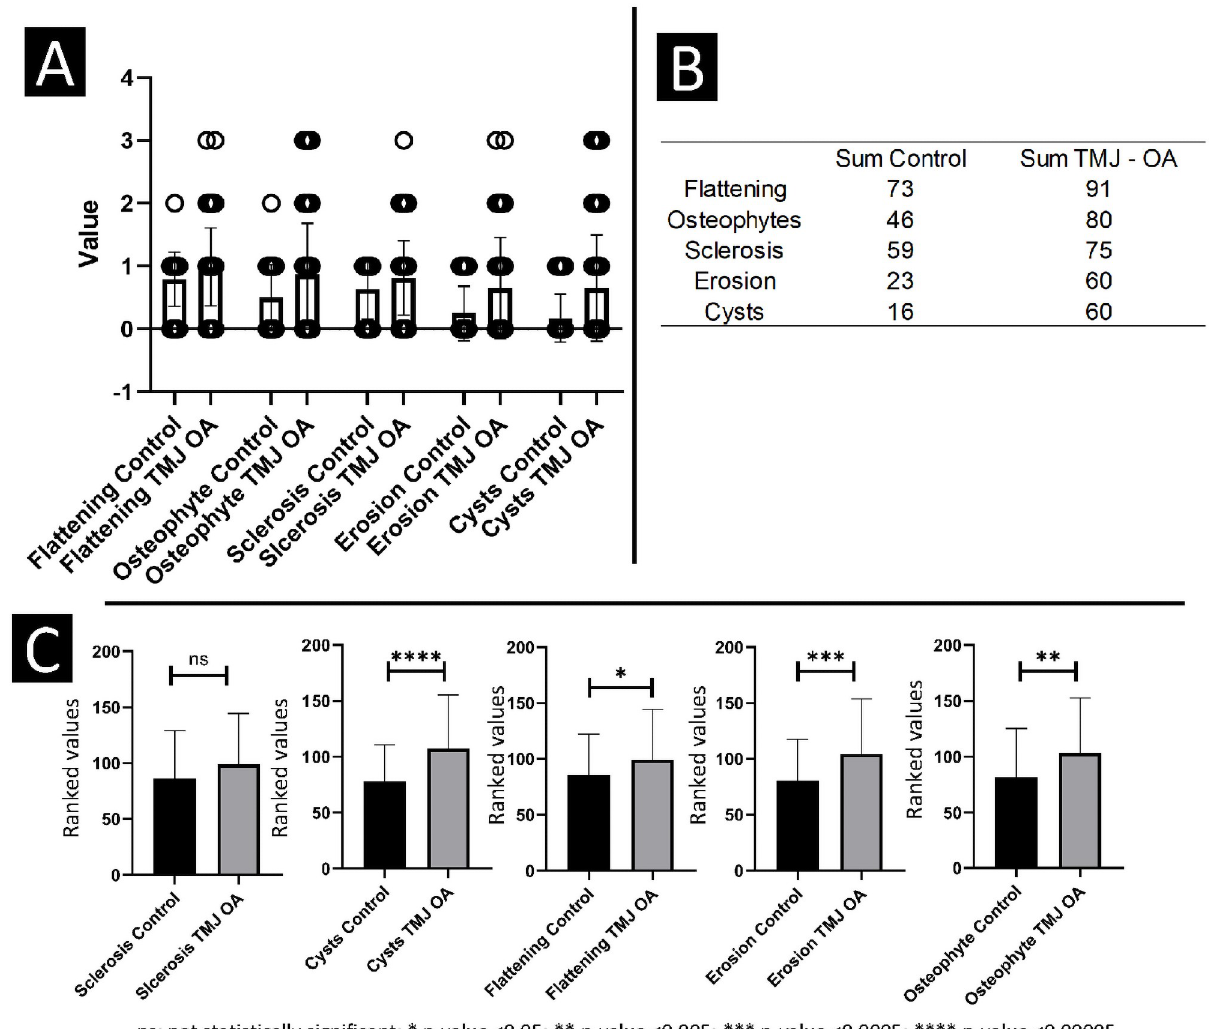
Fig 1. A, B —Descriptive statistics for the radiologists’ consensus. C - Mann Whitney U test for comparison between the groups.